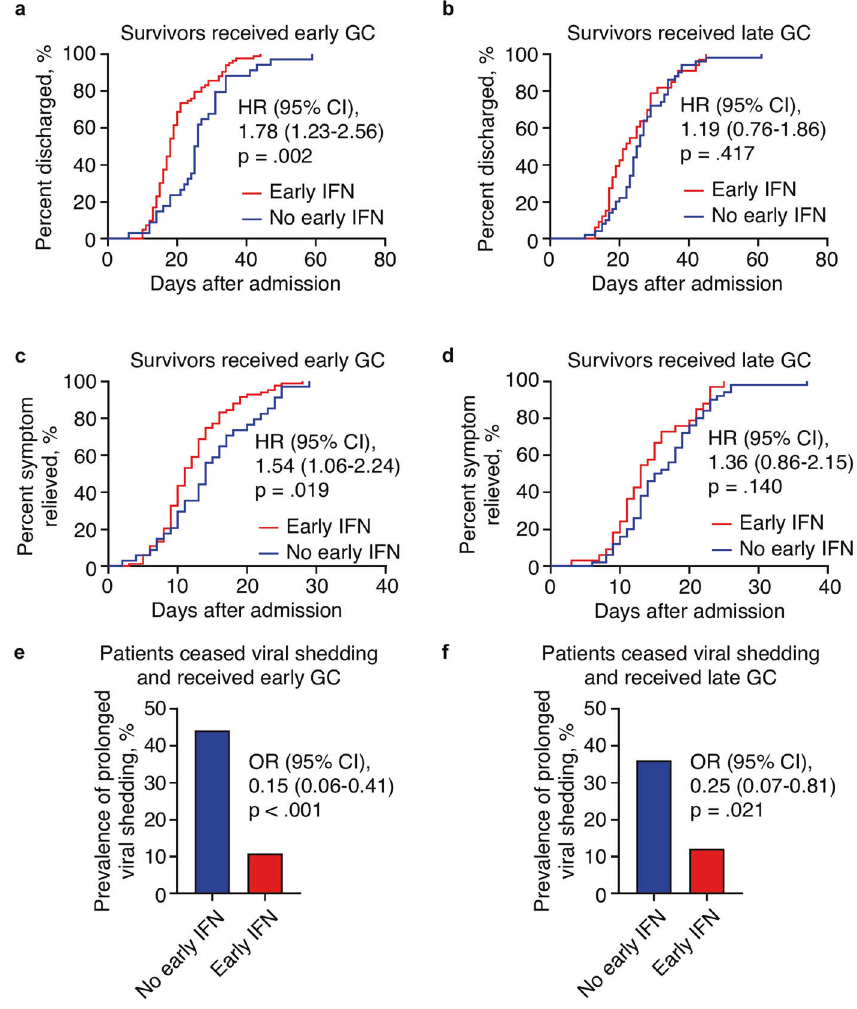
Fig. 3 Association of early IFN therapy with early recovery from COVID-19 required early GC administration. a , b Cumulative incidence curves for hospital discharge among survivors with early ( a ) or late GC administration ( b ). n = 83 (early IFN) and 34 (no early IFN) for a , 33 (early IFN) and 50 (no early IFN) for b . c , d Cumulative incidence curves for symptom relief among survivors with early ( c ) or late GC administration ( d ). n = 83 (early IFN) and 34 (no early IFN) for c , 33 (early IFN) and 50 (no early IFN) for d . e , f Bar graph of PVS prevalence among patients ceased viral shedding before discharge and with early ( e ) or late GC administration ( f ). n = 83 (early IFN) and 38 (no early IFN) for e , 33 (early IFN) and 50 (no early IFN) for